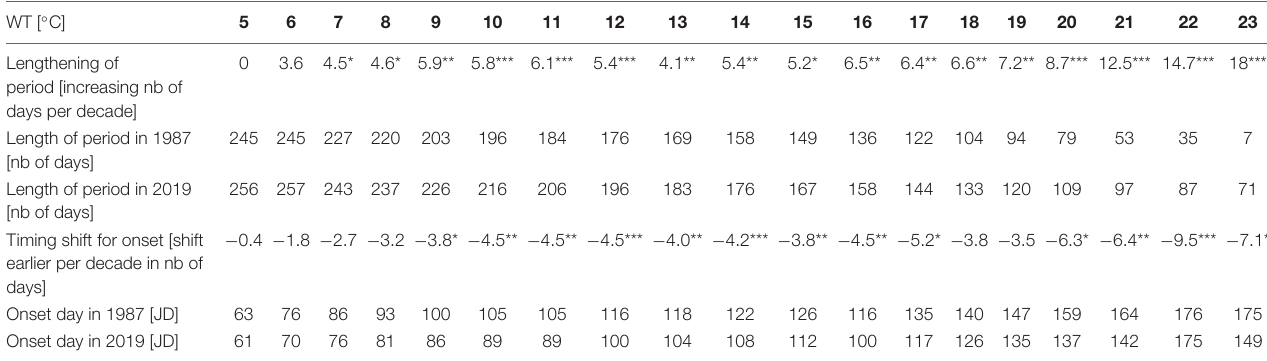
) and the underwater light attenuation Secchi